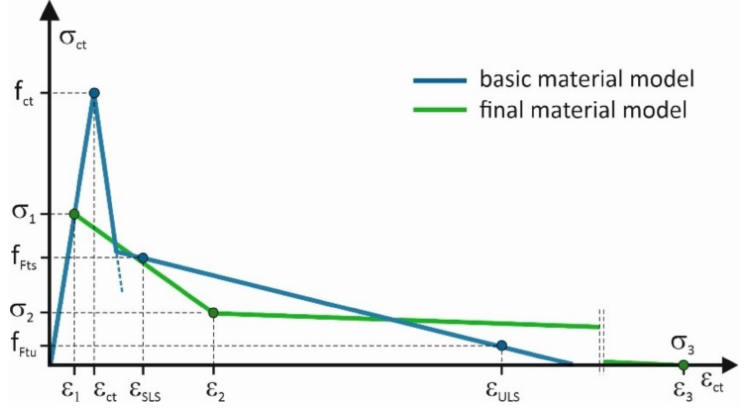
Figure 11. The comparison of the basic and final material